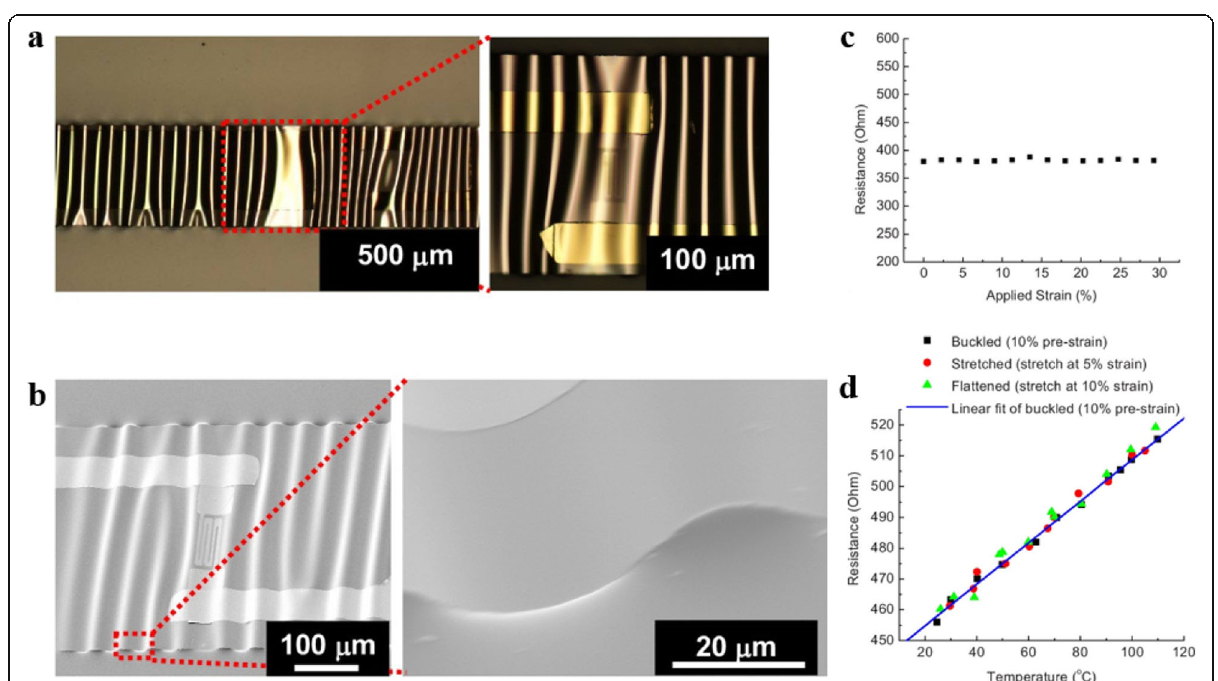
Fig. 7 a Schematic of the stretchable sensors with periodically wavy patterns. b SEM of the stretchable temperature sensor. c Changes in the sensor ’ s resistance value when the sensor strain is continuously stretched from 2.25 to 30%. d The relationship between resistance and temperature of a stretchable sensor with strains of 0%, 5%, and 10%. Adapted with permission from ref. 29. Copyright 2009 AIP